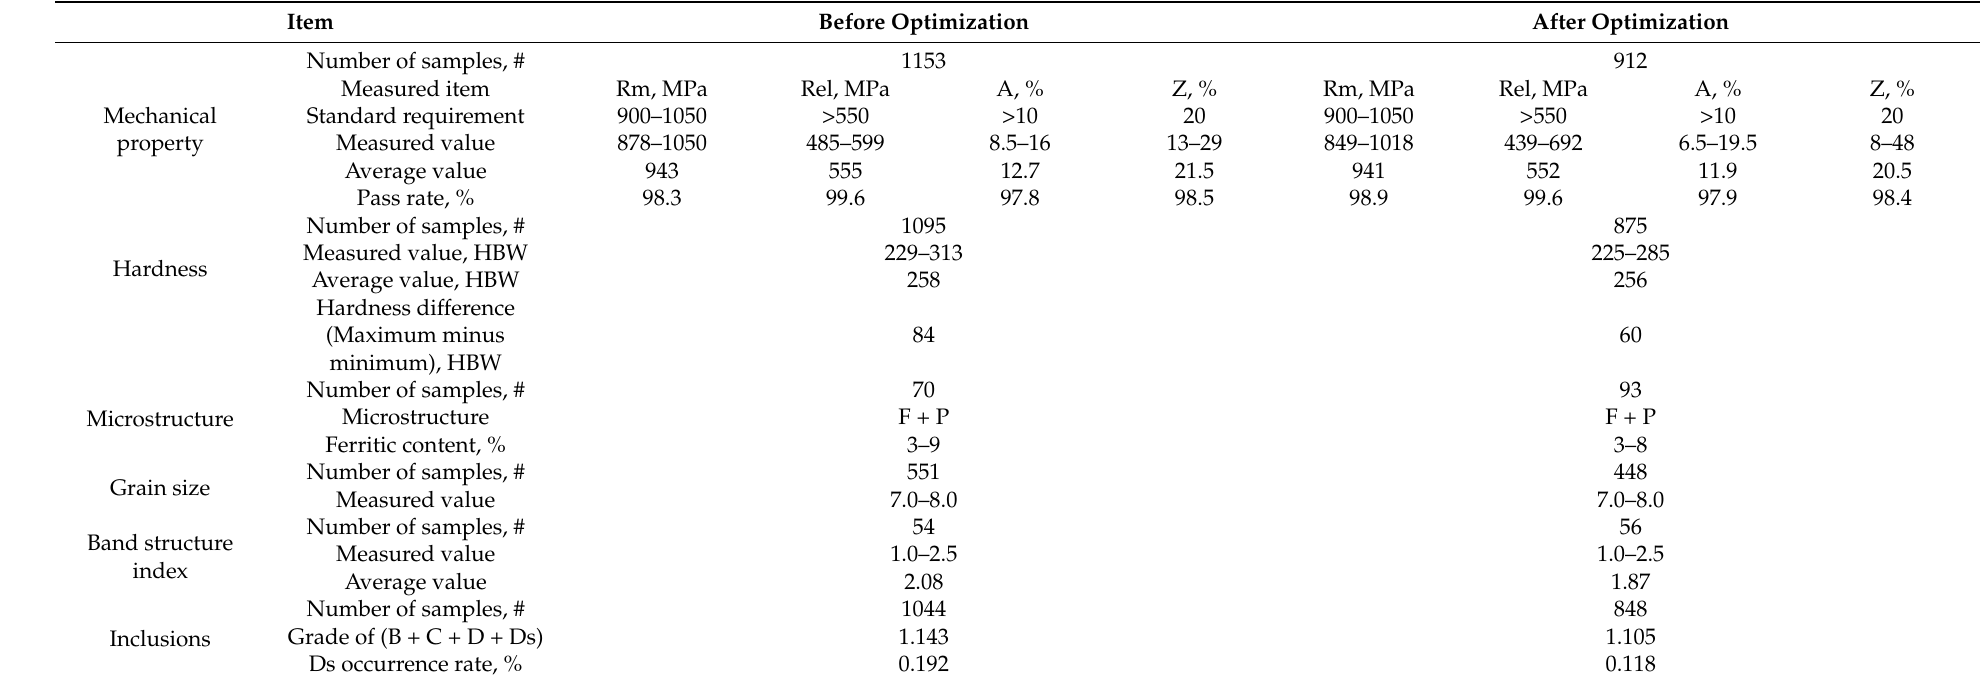
Table 10. Comparison of the quality of rolled products before and after tundish